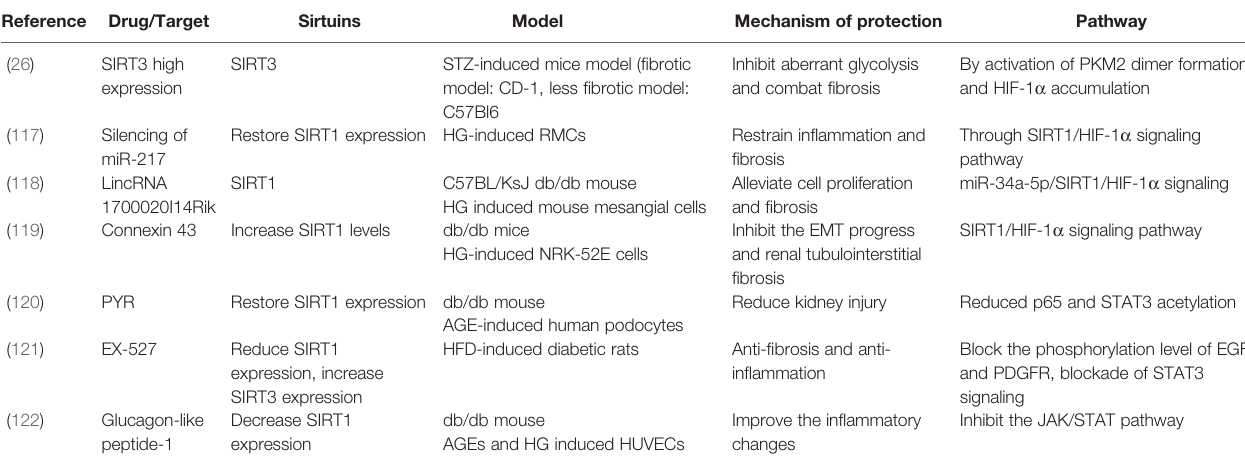
TABLE 8 | DKD studied on STAT and HIF-1 a